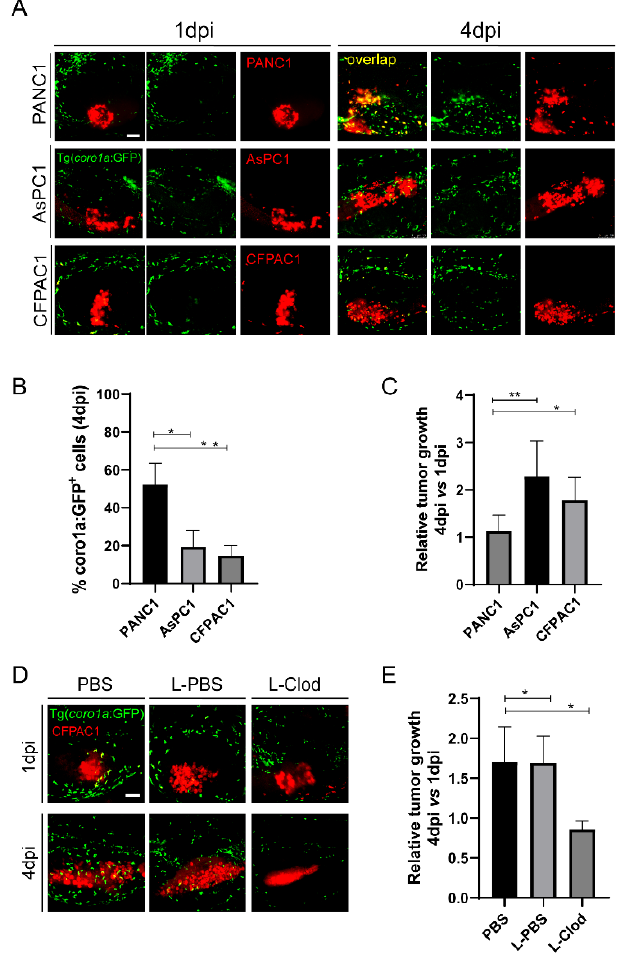
Figure 5. CFPAC1 also hijacks innate immune cells to promote tumor growth in zebrafish. ( A ) Rep- resentative confocal images of PANC1, AsPC1, and CFPAC1 xenografts at 1 dpi and 4 dpi. ( B ) Qual- ification of coro1a: GFP + innate immune cell percentage in PANC1, AsPC1, and CFPAC1 cells at 4 dpi (no. of innate immune cells/no. of tumor cells x 100). Results are shown as means ± SEM from nine different individuals (* p < 0.05, ** p < 0.01, t test). ( C ) Relative tumor growth of PANC1, AsPC1, and CFPAC1. Results are from nine different individuals (* p < 0.05, ** p < 0.01, t test). ( D ) Repre- sentative confocal images of CFPAC1 xenografts in the embryos co-injected with PBS, L-PBS or lip- osome-clodronate (L-clodronate) at 1 dpi and 4 dpi. ( E ) Relative tumor growth of CFPAC1 in PBS-, L-PBS- or L-clodronate-treated groups. Results are from nine different individuals (* p < 0.05, t test). dpi, days post injection. Scale bar, 50 µm.